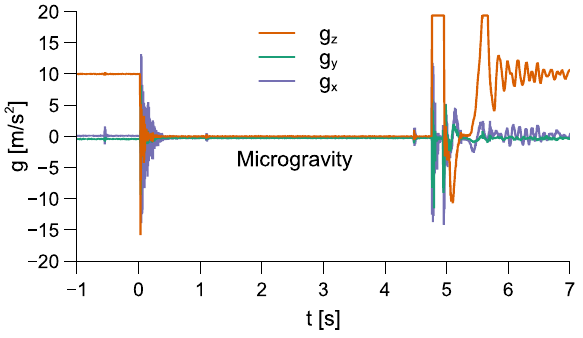
Fig. 6 Acceleration pro fi le of the drop capsule measured during the 4.7 s of free fall at the Bremen Drop Tower. Three-dimensional acceleration components are displayed separately, with z denoting the vertical drop direction.